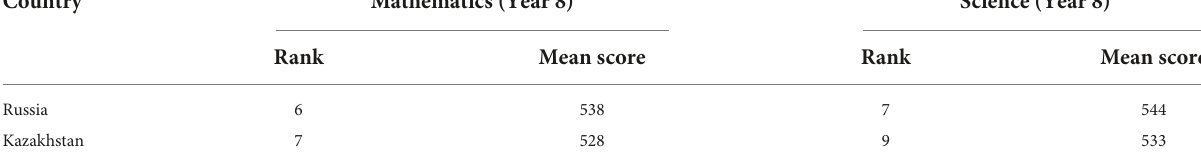
TABLE 5 TIMSS, 2015 testing results for Russia and Kazakhstan. Country